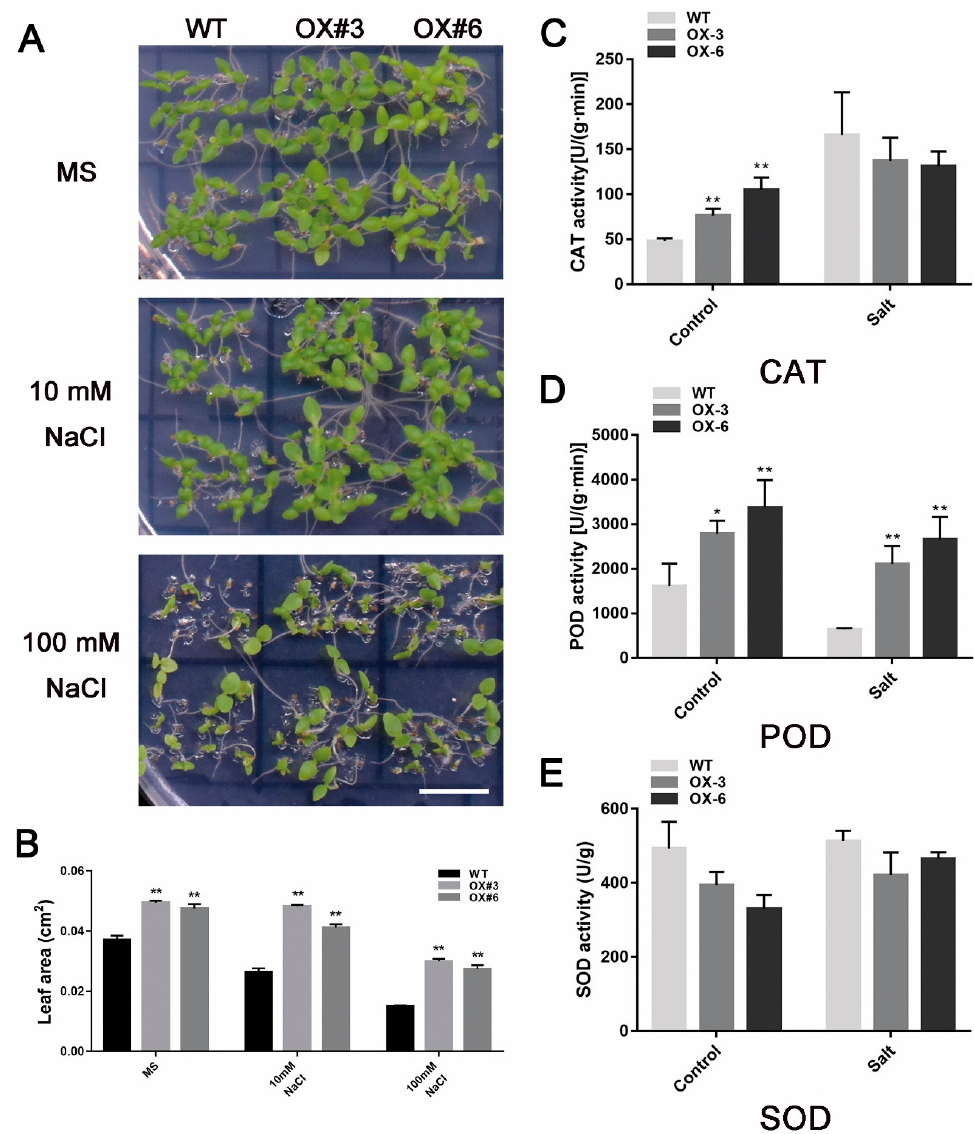
Figure 4. Comparison of resistance to salinity of 35S::FaNAC2 and wild-type (WT) lines. ( A ) Analysis of 13 DAG seedlings of 35S::FaNAC2 and WT seeds under salt and control treatments. OX: overexpression. ( B ) Leaf area of 35S::FaNAC2 and WT 13 DAG seedlings under salt and control treatments. ( C – E ) Enzyme activity of several enzymes related to plant resistance to salt. CAT: Catalase; POD: Peroxidase; SOD: Superoxide dismutase. The scale bar represents 1 cm. Bars are means ( ± S.D.) of three independent experiments (Student’s t –test; * p < 0.05; ** p <